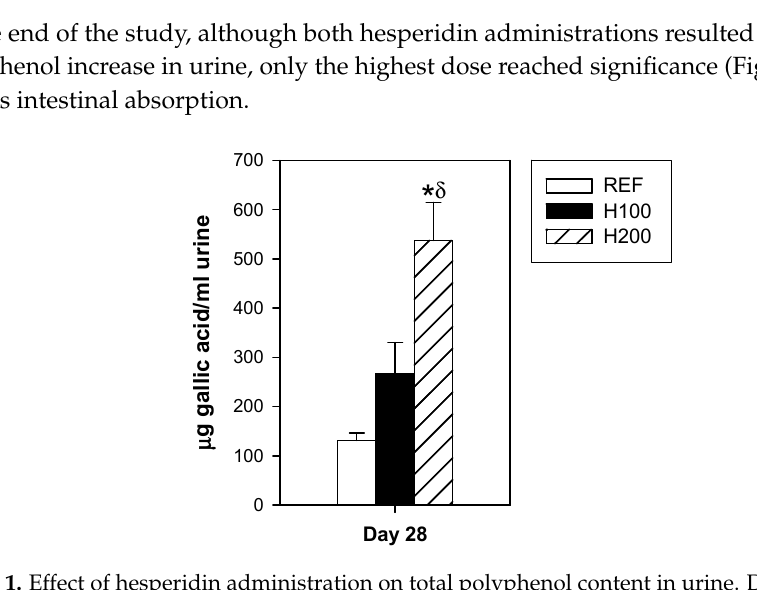
Figure 1. Effect of hesperidin administration on total polyphenol content in urine. Data are expressed as mean ± standard error ( n = 5–6). Statistical difference: * p < 0.05 versus REF group, δ p < 0.05 versus H100 group (one-way ANOVA).